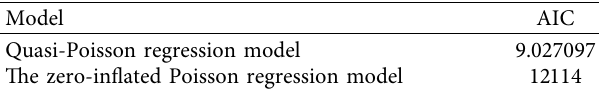
Table 1: Comparison of quasi-Poisson and zero-infated regression models based on AIC.